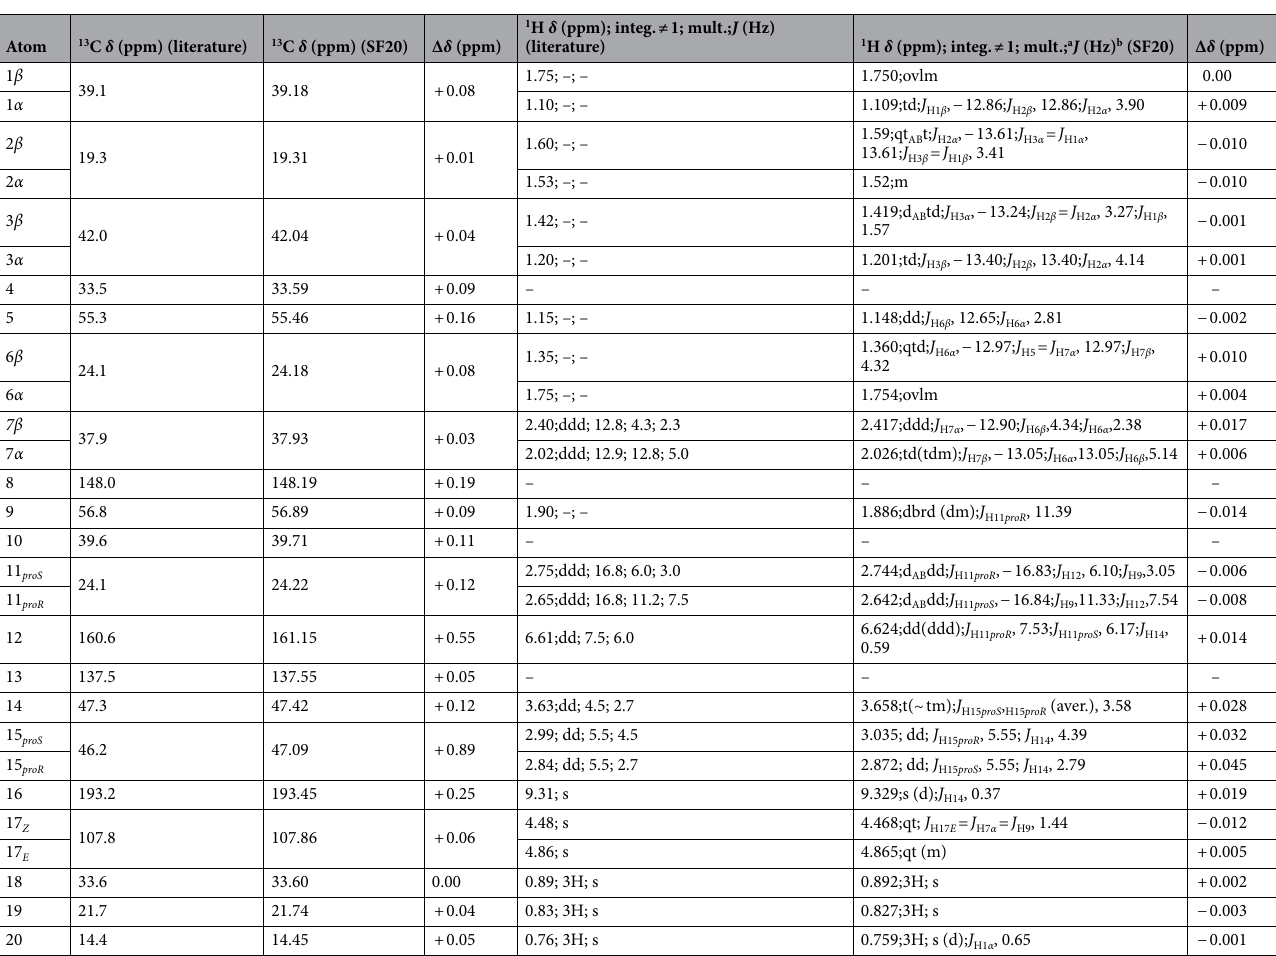
Table 1. Comparison of 1 H and 13 C NMR data of SF20 (Cm epoxide) from Curcuma mutabilis with Alpinia epoxide reported from Alpinia chinensis in CDCl 3 . a Multiplicities in parentheses after application of an exponential (− 0.7 Hz)–Gaussian (+ 0.3 Hz) window function. b Large geminal couplings assumed to